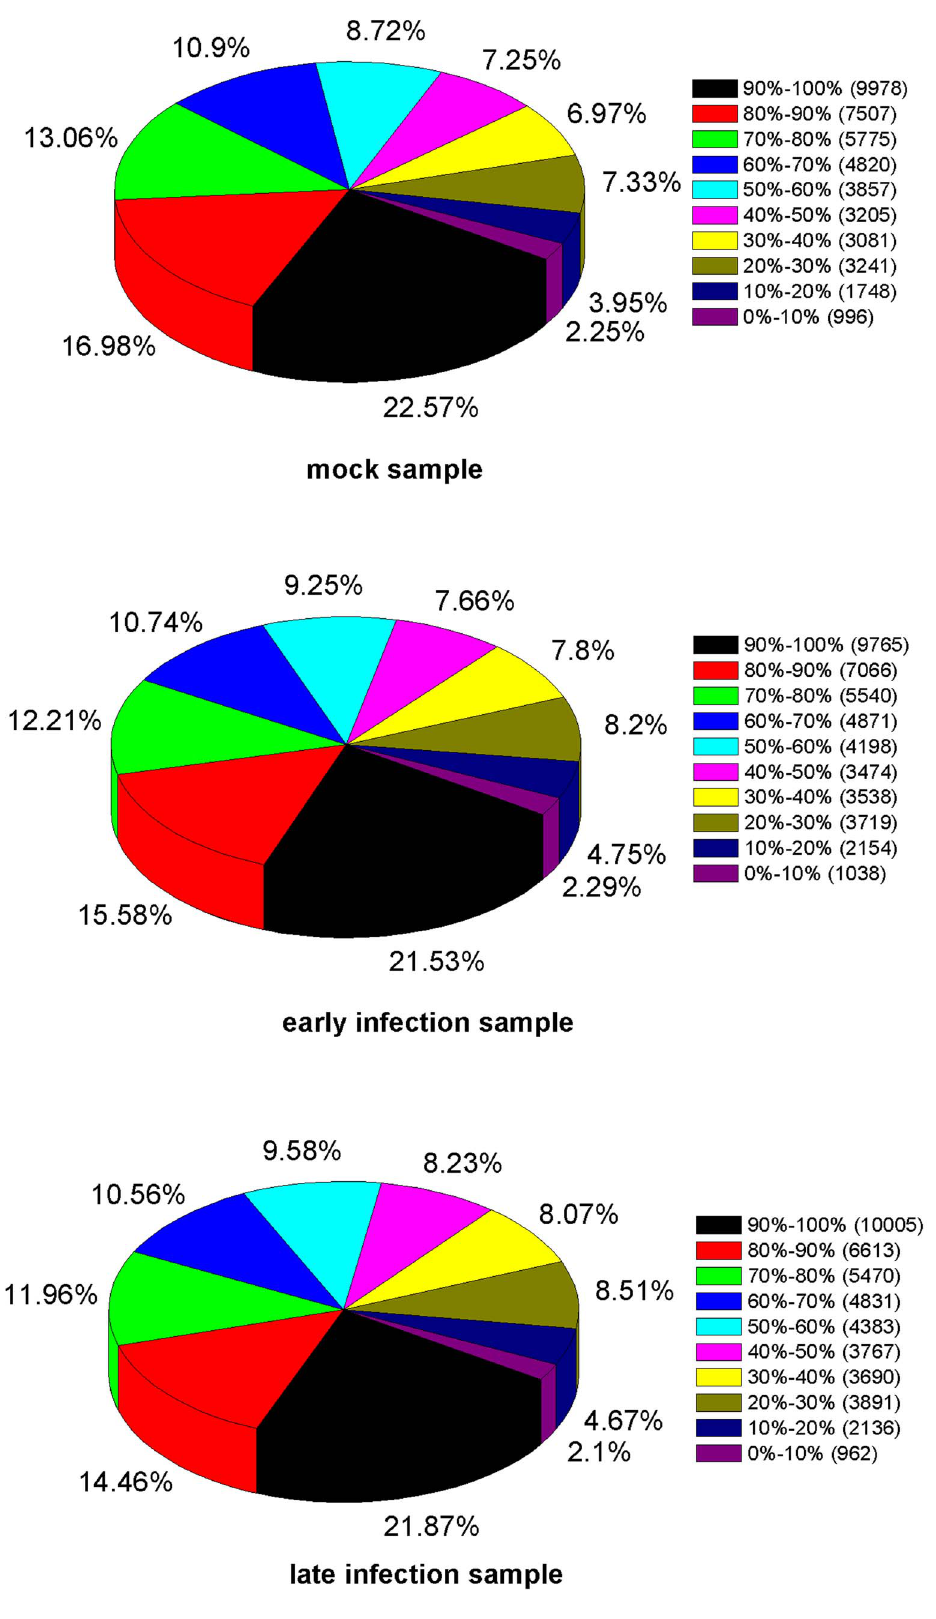
Figure 7. Distributions of genes’ coverage of mock, early infection and late infection samples. Genes’ coverage is used to assess the depth of DGE sequencing. It refers to the percentage mapped by reads of each gene.